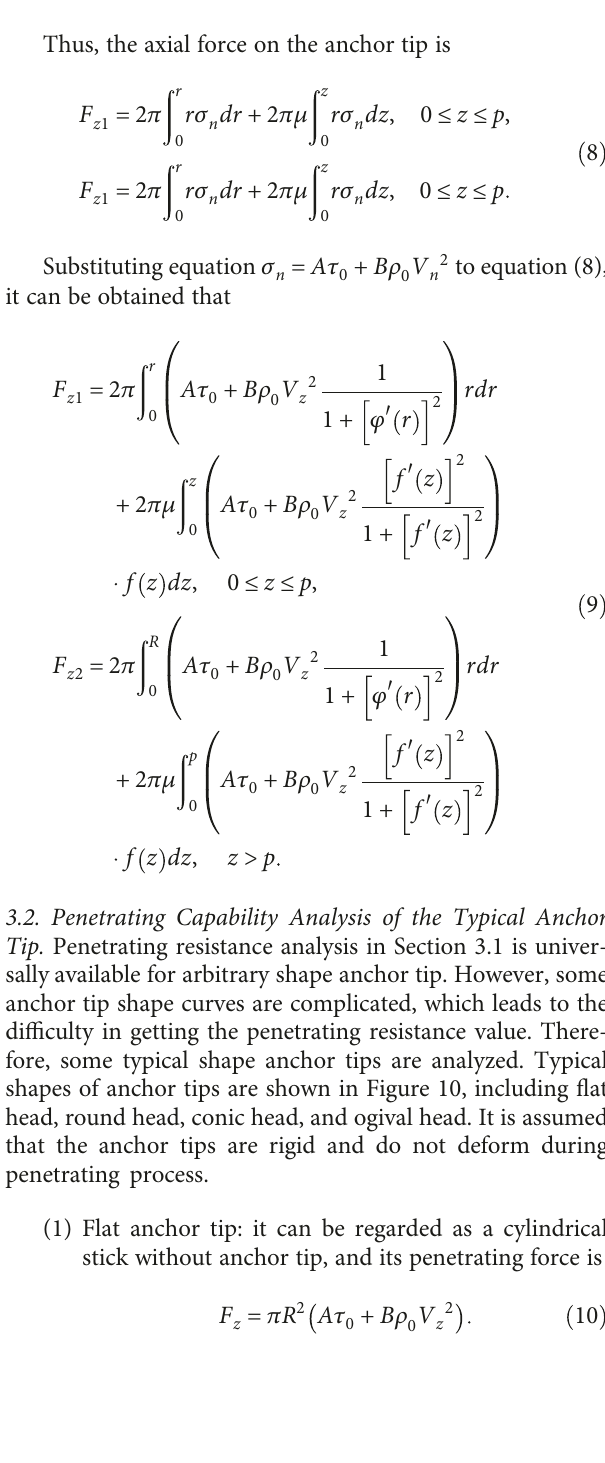
Figure 8: Schematic diagram of spherical cavity expansion model and constitutive relation of medium.